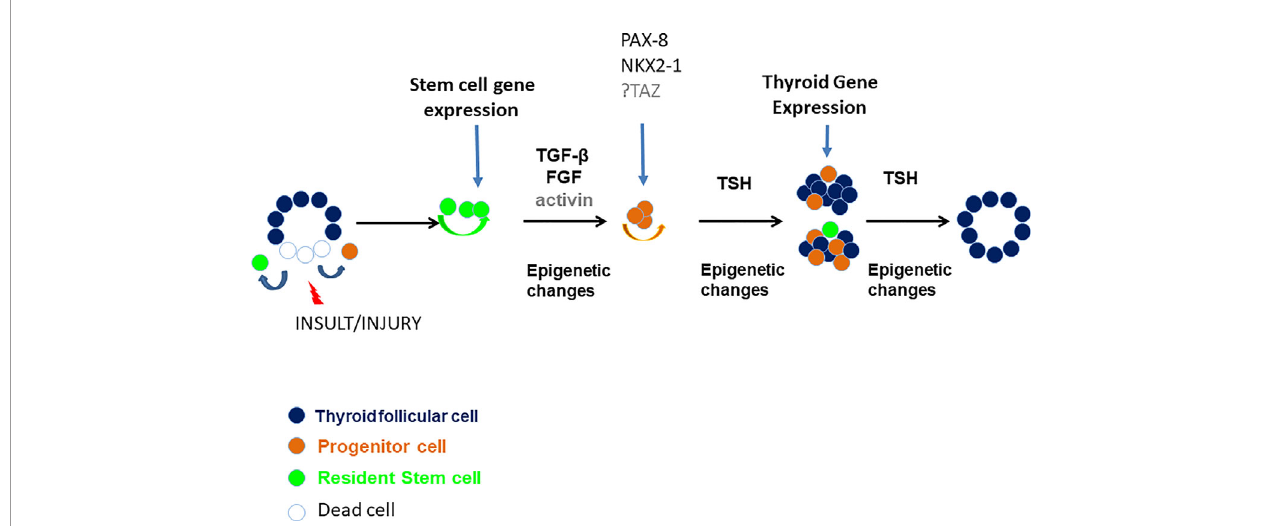
FIGURE 8 | A proposed model of thyroid gland damage and regeneration. Various insults and injuries such as xenobiotics or pathophysiological conditions (i.e. iodide de fi ciency, autoimmune disease, partial thyroidectomy, etc.) may damage thyroid follicles and induce immature thyroid cells (such as resident stem cells or resident progenitor thyroid cells) to self-renew and/or differentiate through unclear mechanisms but likely involving TGF- b , FGF, activin, and TSH and involving epigenetic modi fi cations resulting in repair/regeneration of a damaged thyroid